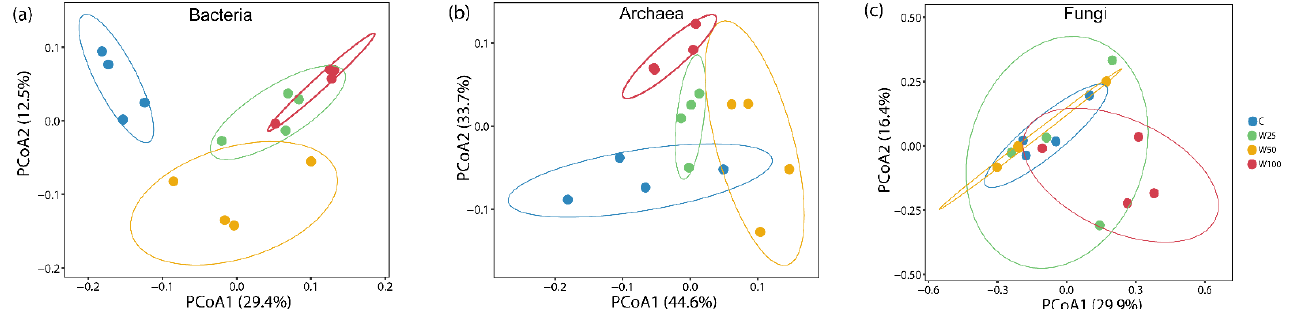
Figure 2. PCoA plots of Bray–Curtis dissimilarities highlighting that bacterial ( a ), archaeal ( b ), and fungal ( c ) communities were significantly different in composition depending on water addition treatments. Circles represent samples from each treatment. C = ambient precipitation; W25 = ambient precipitation +25% of local annual mean precipitation; W50 = ambient precipitation +50% of local annual mean precipitation; W100 = ambient precipitation +100% of local annual mean precipitation.